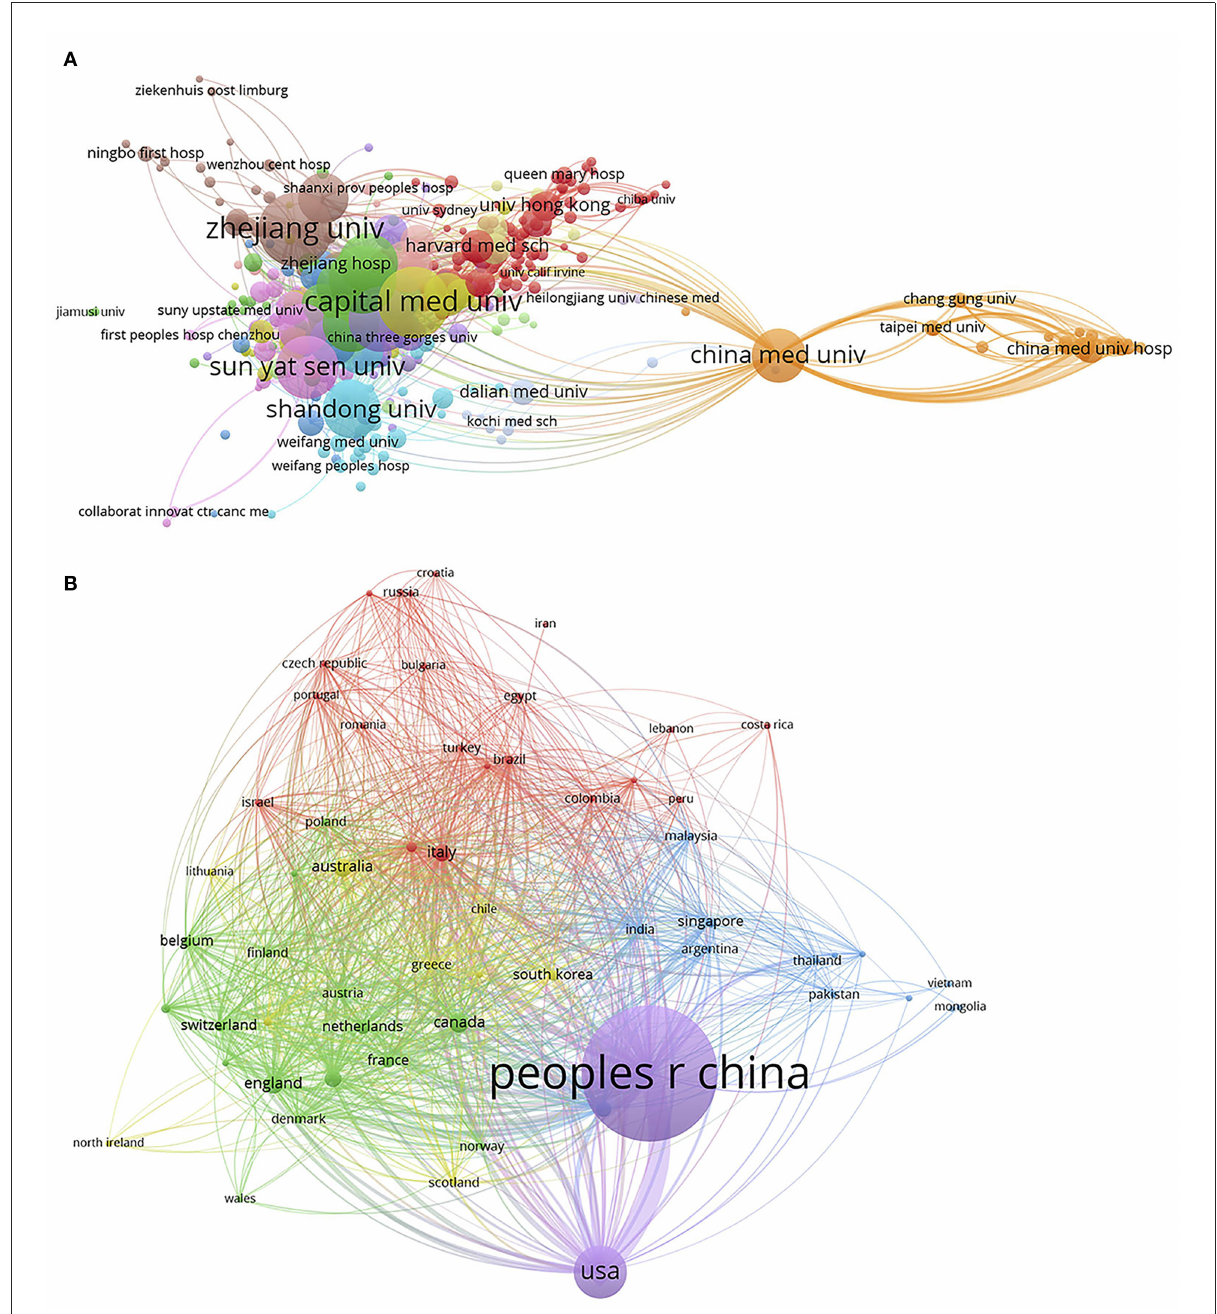
FIGURE5 National and international Co-authorship network. Cluster regarding collaboration in Critical Care Medicine researches was mapped between authors from different affiliations of China (i.e national collaboration, A ) or between authors from China and those from other countries (i.e international collaboration, B ) from 2001 to 2020. Each circle indicated an affiliation of China, or one country. The circle size represented the number of publications and the lines between two circles indicated co-appearance of two affiliations or countries in one article. Color of each circle indicated the cluster. The thickness of lines indicated strength of linkage calculated by the number of publications co-authored by the different affiliations or countries.